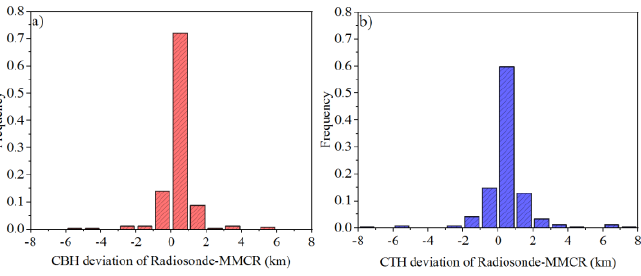
Figure 15. Distributions of the deviations of the CBHs and CTHs detected by the radiosonde and MMCR from December 2020 to November 2021. ( a ) CBH deviation and ( b ) CTH deviation.